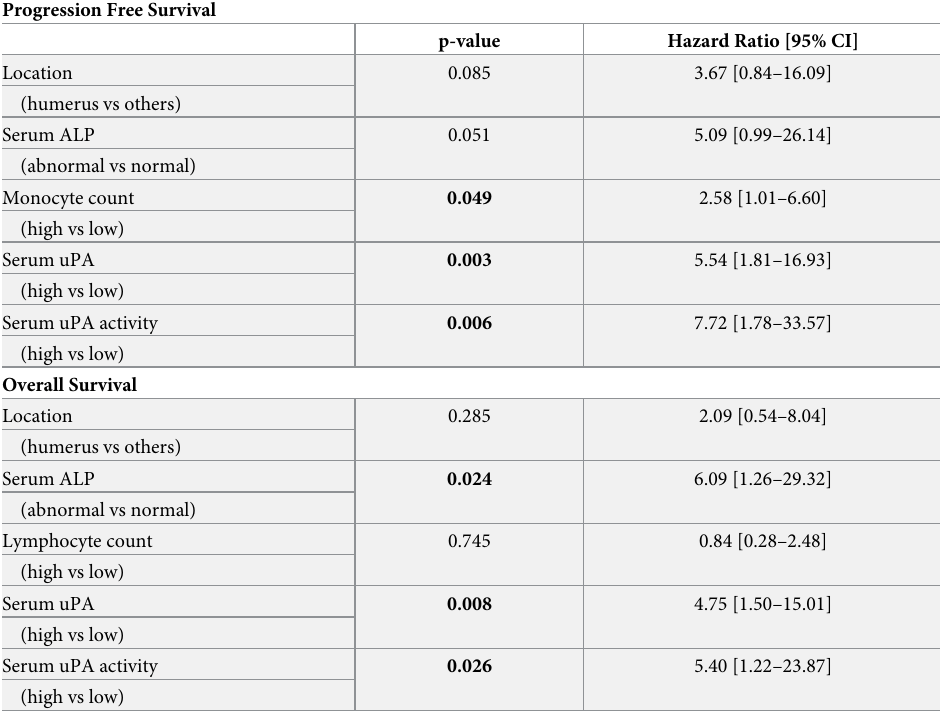
Table 7. Risk factors in 25 osteosarcoma-bearing dogs with p-values and hazard ratios in multivariate analysis. Progression Free